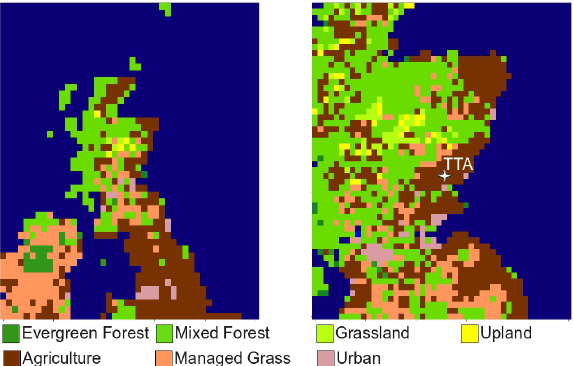
Fig. 1. Land classification map used covering the spatial extent of the model domain. The left panel is the parent domain at 18 x 18 km, right panel is nested domain at 6 x 6 km. The star indicates the location of tall tower Angus. The map used in WRF-SPA is a modified MODIS land cover map provided with the WRF model. The fractions of each land cover within the nested domain are crop = 36 %, evergreen forest = 1 %, mixed forest = 42 %, grassland = 2 %, managed grassland = 13 %, upland = 3 %, urban = 3 %.